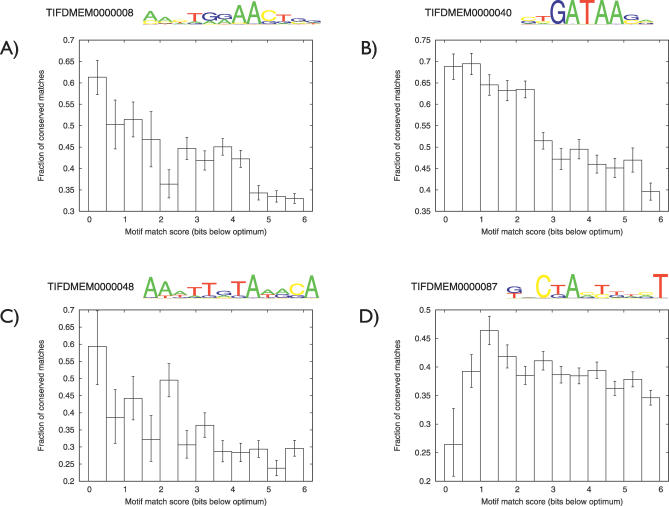
Example Plots Showing the Fraction of Motifs in Each Score Bin That Are Conserved among Three Drosophila SpeciesIncreasing bin numbers indicate worse scores. The error bars in this plot indicate 99% confidence intervals calculated from a β distribution.(A–C) Show results for motifs that are significantly overconserved.(D) Shows an underconserved motif.